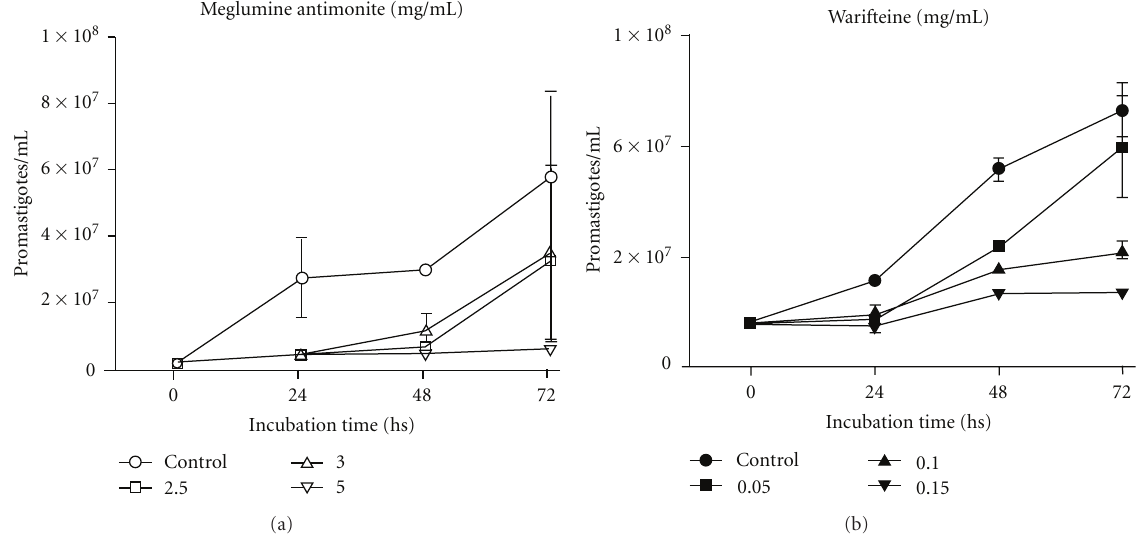
Figure 1: In vitro e ff ects of di ff erent concentrations of meglumine antimonite (a) and warifteine (b) on the growth kinetics of L. chagasi promastigotes forms. Results are expressed as the mean of triplicate